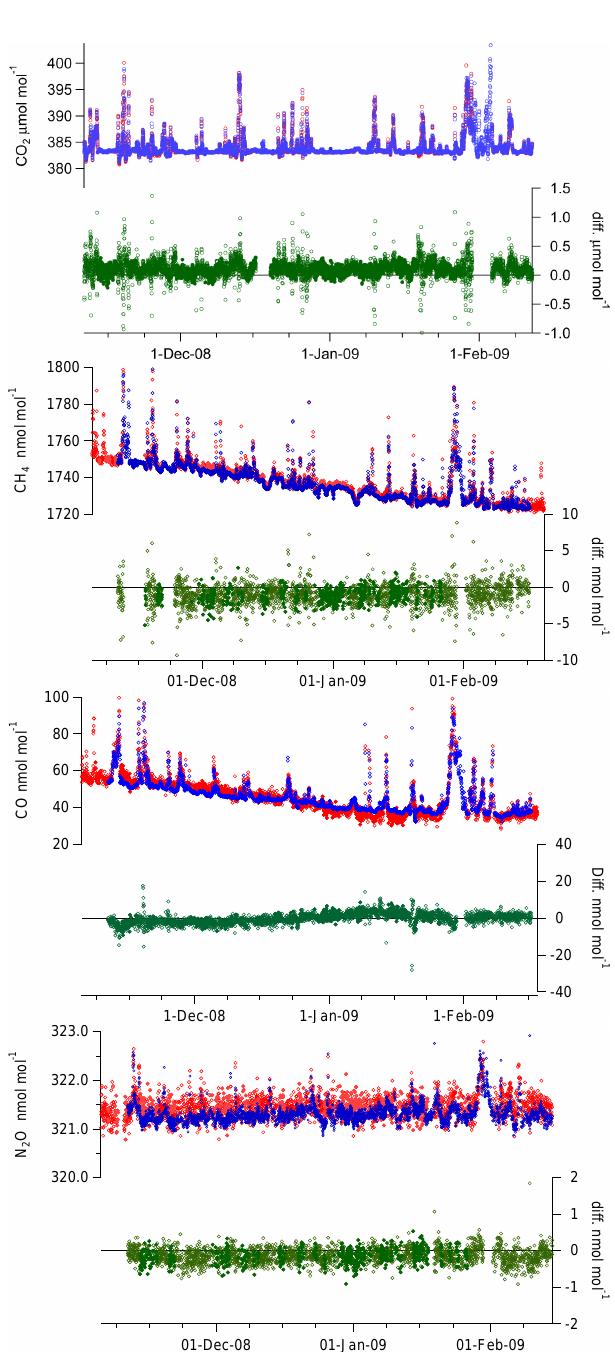
Fig. 8. Comparisons of FTIR measurements over a 3-month cam- paign at Cape Grim with LoFlo (CO 2 ) and AGAGE (CH 4 , CO, N 2 O) GC measurements. Red: LoFlo/AGAGE. Blue: FTIR. Upper panels: time-coincident measurements. Lower panels: difference. Full circles represent baseline air periods, open circles non-baseline conditions. From (Griffith et al., 2011) with updates to AGAGE CO data calibration (see text for